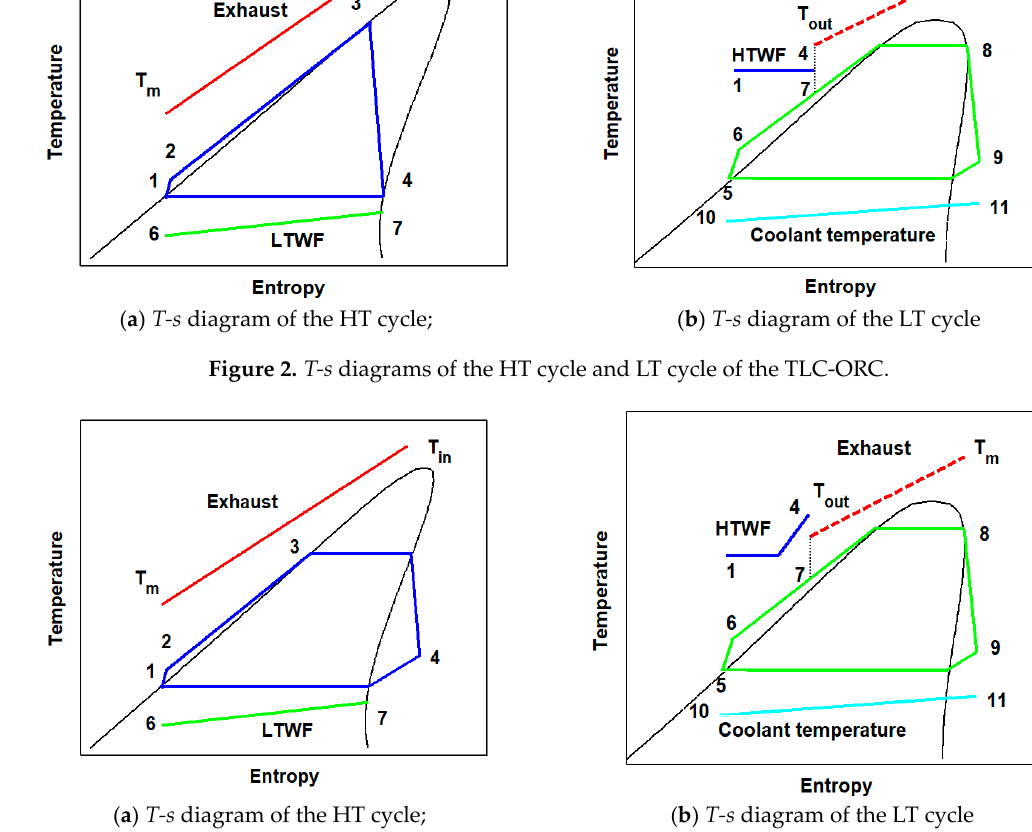
Figure 3. T-s diagrams of the HT cycle and LT cycle of the conventional dual-loop ORC.